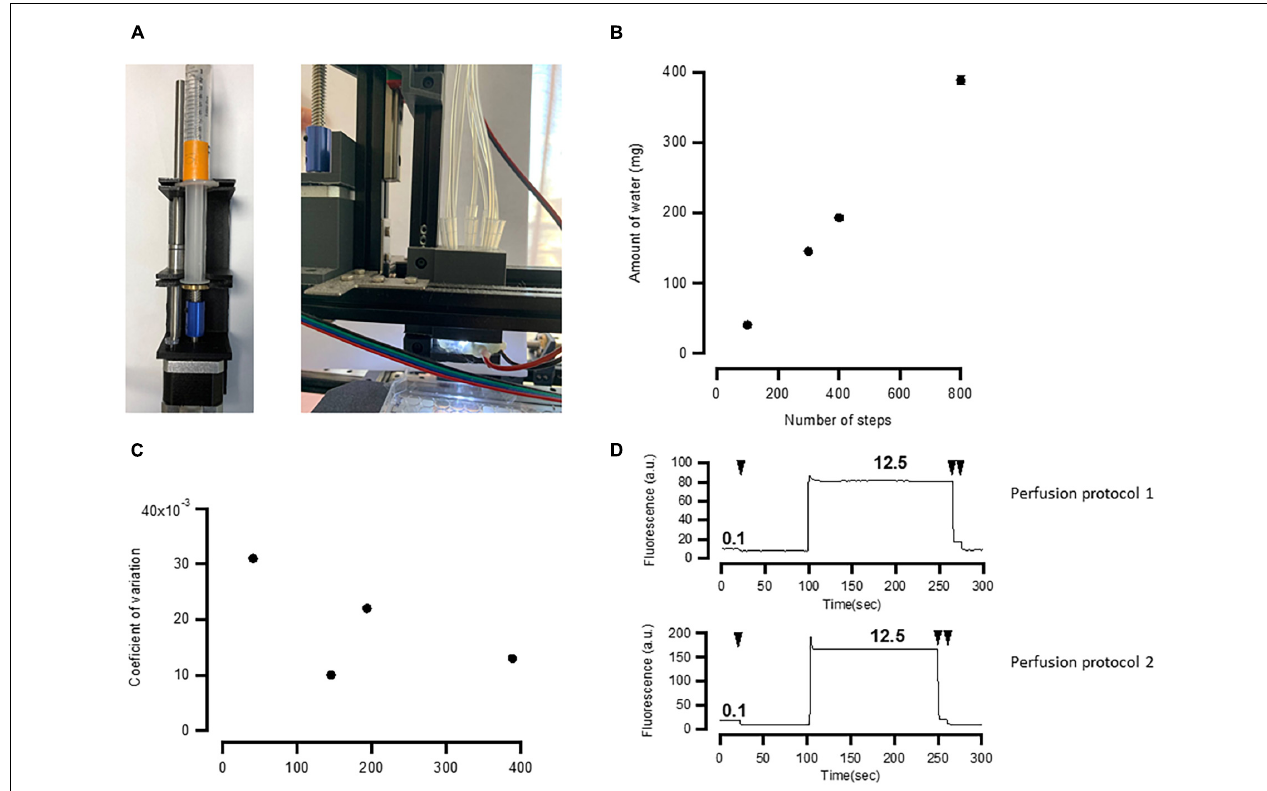
FIGURE 5 | Application manifold performance. (A) Assembled pump and solution application manifold. (B) Relationship between number of steps and the amount of water ejected by the 10-ml syringe. The relationship is linear. (C) Random error of the pumps calculated expressed as coefficient of variation of 10 measurements. (D) Application and washout of fluorescent solution (Lucifer Yellow) recorded by the fluorescent microscope. See details in the main text. Washouts are shown by arrows. Both perfusion protocols exhibit ∼ 99% washout. Numbers indicate the concentration of fluorescent compound in µ g/ml. Two back-to-back washouts were more effective in both protocols, as revealed by the further decrease in fluorescence after the second